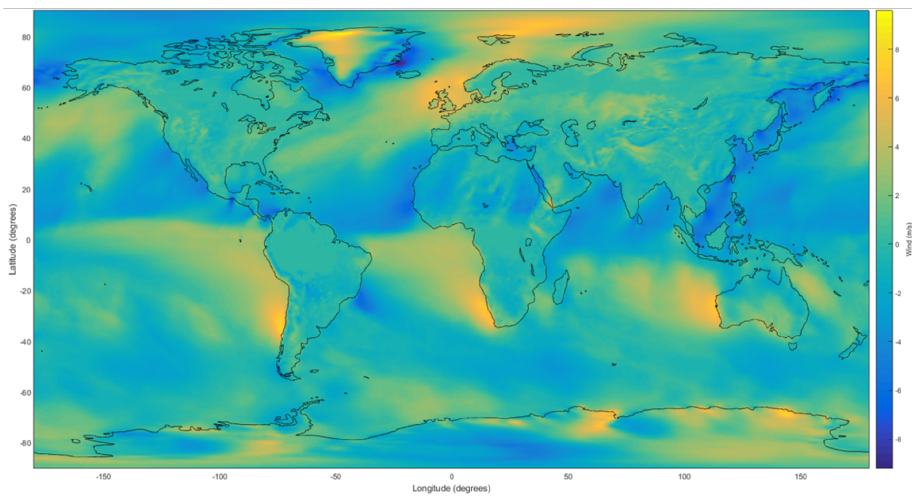
Figure 2. Example visualization of the MERRA-2 winds at a specific time and altitude.